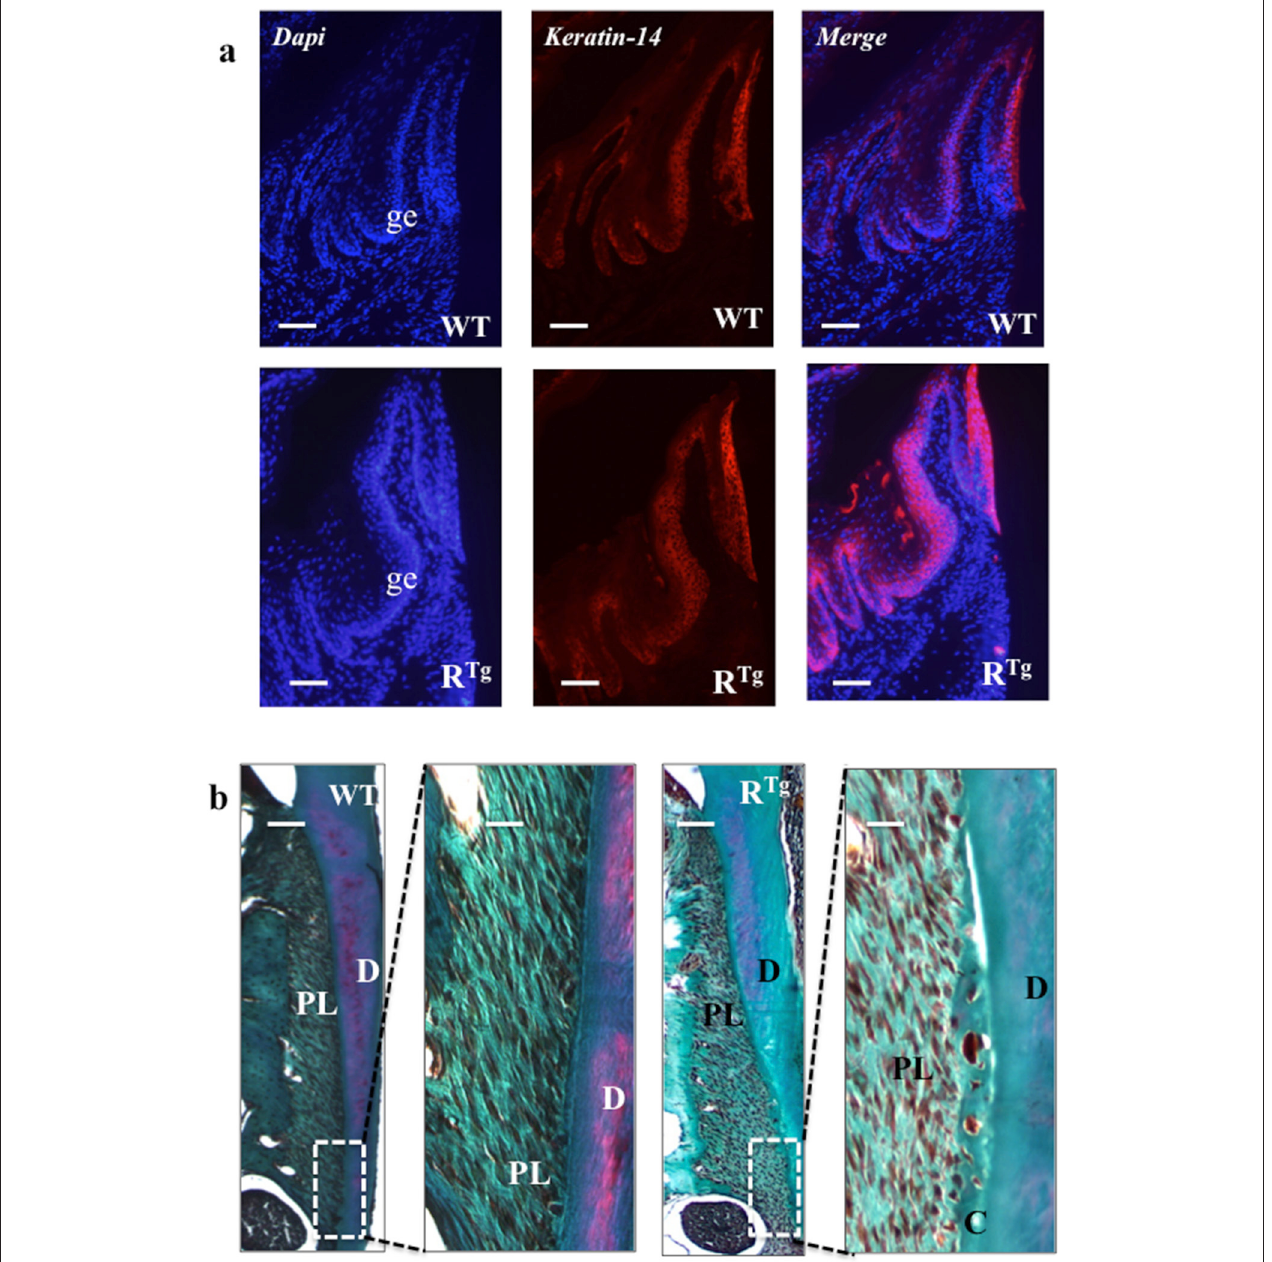
FIGURE 4 | Histological analysis of gingival epithelium and periodontal ligaments at 25 days. At this age, an important thickening of gingival epithelium was already clearly visible in R Tg mice relative to WT mice (a) whereas we observed no difference in the structure of the periodontal ligament (b) . Masson trichrome staining showed no difference regarding periodontal tissues or ligaments between WT and R Tg mice. AB, alveolar bone; D, dentin; C, cementum; PL, periodontal ligament. Scale bars correspond to 50 µ m in a , 10 µ m in b and 50 µ m in enlarged b .